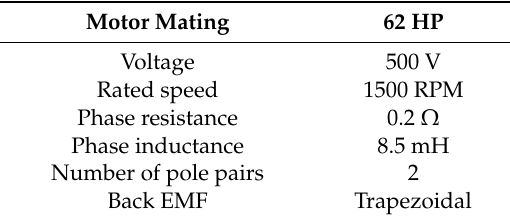
Table 5. BLDC motor